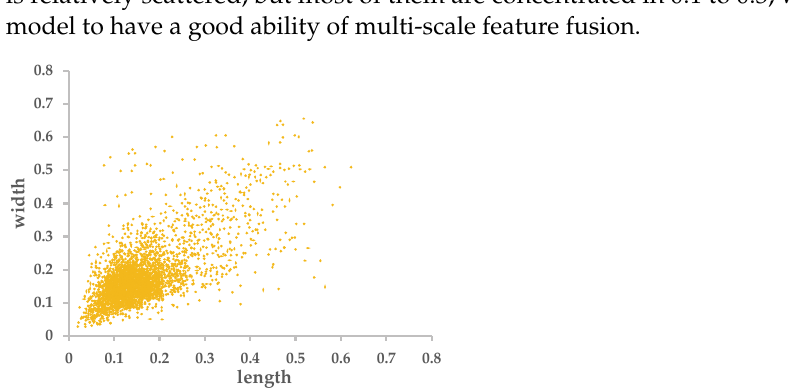
Figure 11. The number and proportion of each species. 4.1. Evaluation Indicators The Intersect Over Union (IOU) threshold parameter needs to be set for the model prediction. When the IOU > 0.5, the detection is successful. In this paper, the mean Aver ‐ age Precision (mAP), Frames Per Second (FPS), and model size are used as evaluation indicators. First, it introduces Precision and Recall. The Precision is the ratio of correctly predicted positive classes to all predicted positive classes, and the Recall is the ratio of correctly predicted positive classes to all actual positive classes. The formulas are shown as follows.